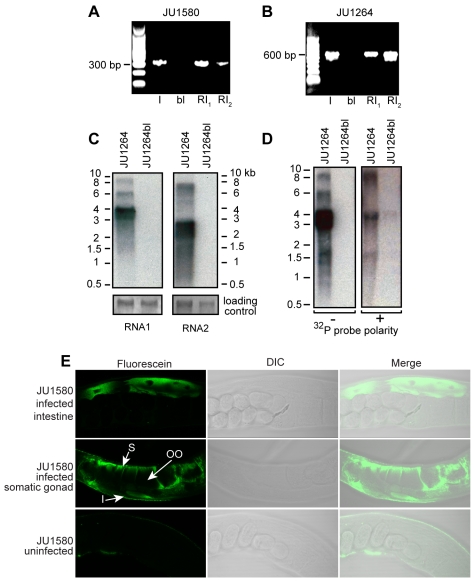
Molecular evidence of viral infection.(A) RT-PCR detection of the Orsay virus in the original JU1580 wild isolate (I), after bleaching (bl) and after re-infection by a 0.2 µM filtrate after 7 d (RI1) and 3 wk (RI2) of culture at 23°C. (B) RT-PCR detection of the Santeuil virus in the original wild isolate (I), after bleaching (bl) and after re-infection by a 0.2 µM filtrate after 4 d (RI1) and 4 wk (RI2) at 23°C. (C) Northern blots of Santeuil virus RNA1 and RNA2 segments hybridized using a double-stranded DNA probe. (D) Northern blots of Santeuil virus RNA1 segment using + and − sense riboprobes. (E) RNA FISH with a probe targeting Orsay virus RNA1 segment. Representative JU1580bl animals following infection by Orsay virus (top and middle rows) or uninfected (bottom row). S corresponds to ovary sheath cells, OO is an oocyte, and I is an intestinal cell.